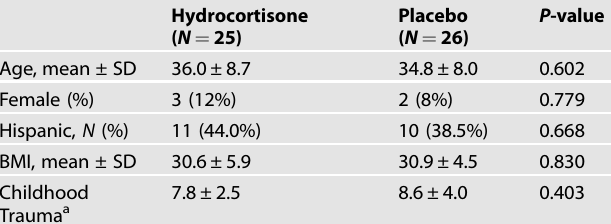
Fig. 3 a Time-course difference of NR3C1 and FKBP5 methylation between PTSD responders ( N = 20) and nonresponders ( N = 22). b Relationship of NR3C1 and FKBP5 methylation between pretreatment (T1) and PTSD-symptom severity at three months post treatment (T3) grouped by clinical outcome and treatment.Statistical signi fi cance was set at p < 0.05. Table 3. Clinical and demographic characteristics of the